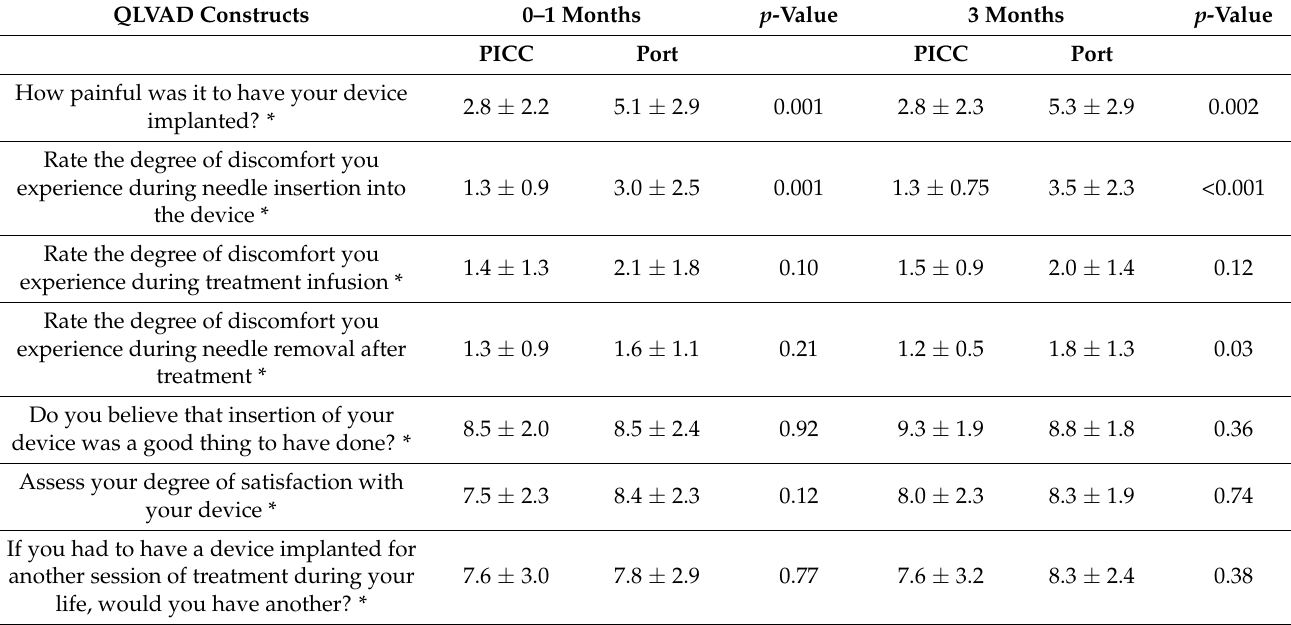
Table 2. Mean QLVAD scores and standard deviation (SD) at 1 month and 3 months for treatment-related discomfort and pain and overall satisfaction between the PICC line and the port